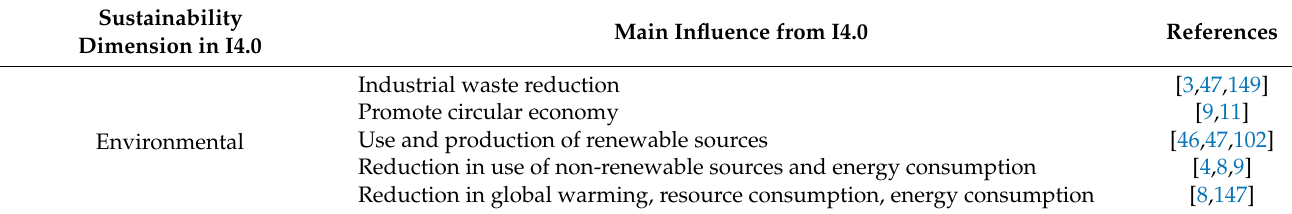
Main Influence from